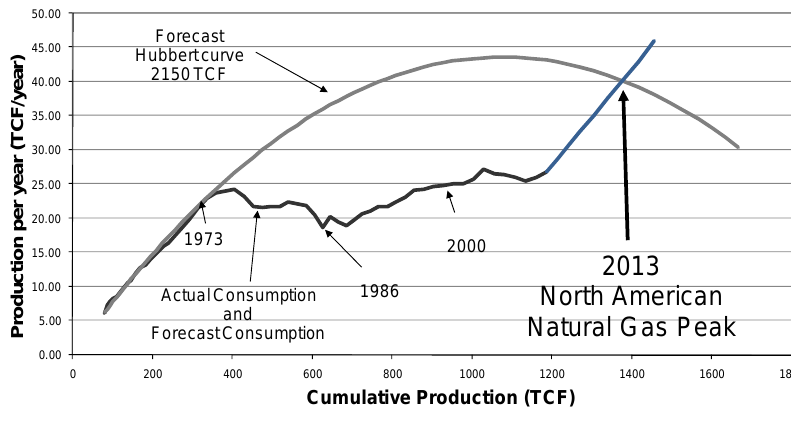
Figure 5. Forecast Consumption.